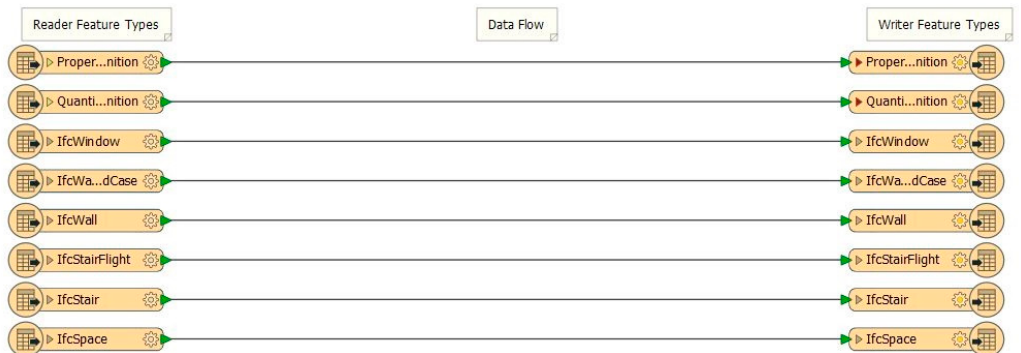
Figure 6. IFC to Xls workflow (example).